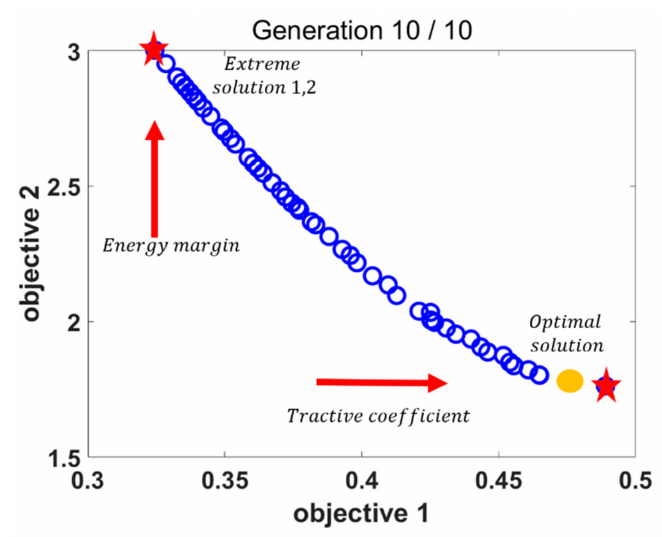
Figure 12. Multi-objective optimization results based on the NSGA-II.